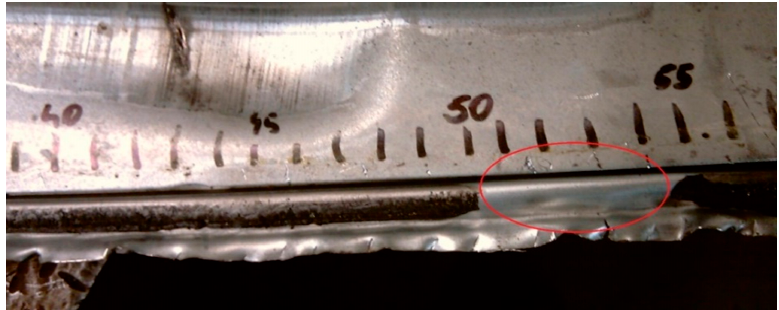
Figure 2. View of example of adhesive joint defects—lack of adhesive path.